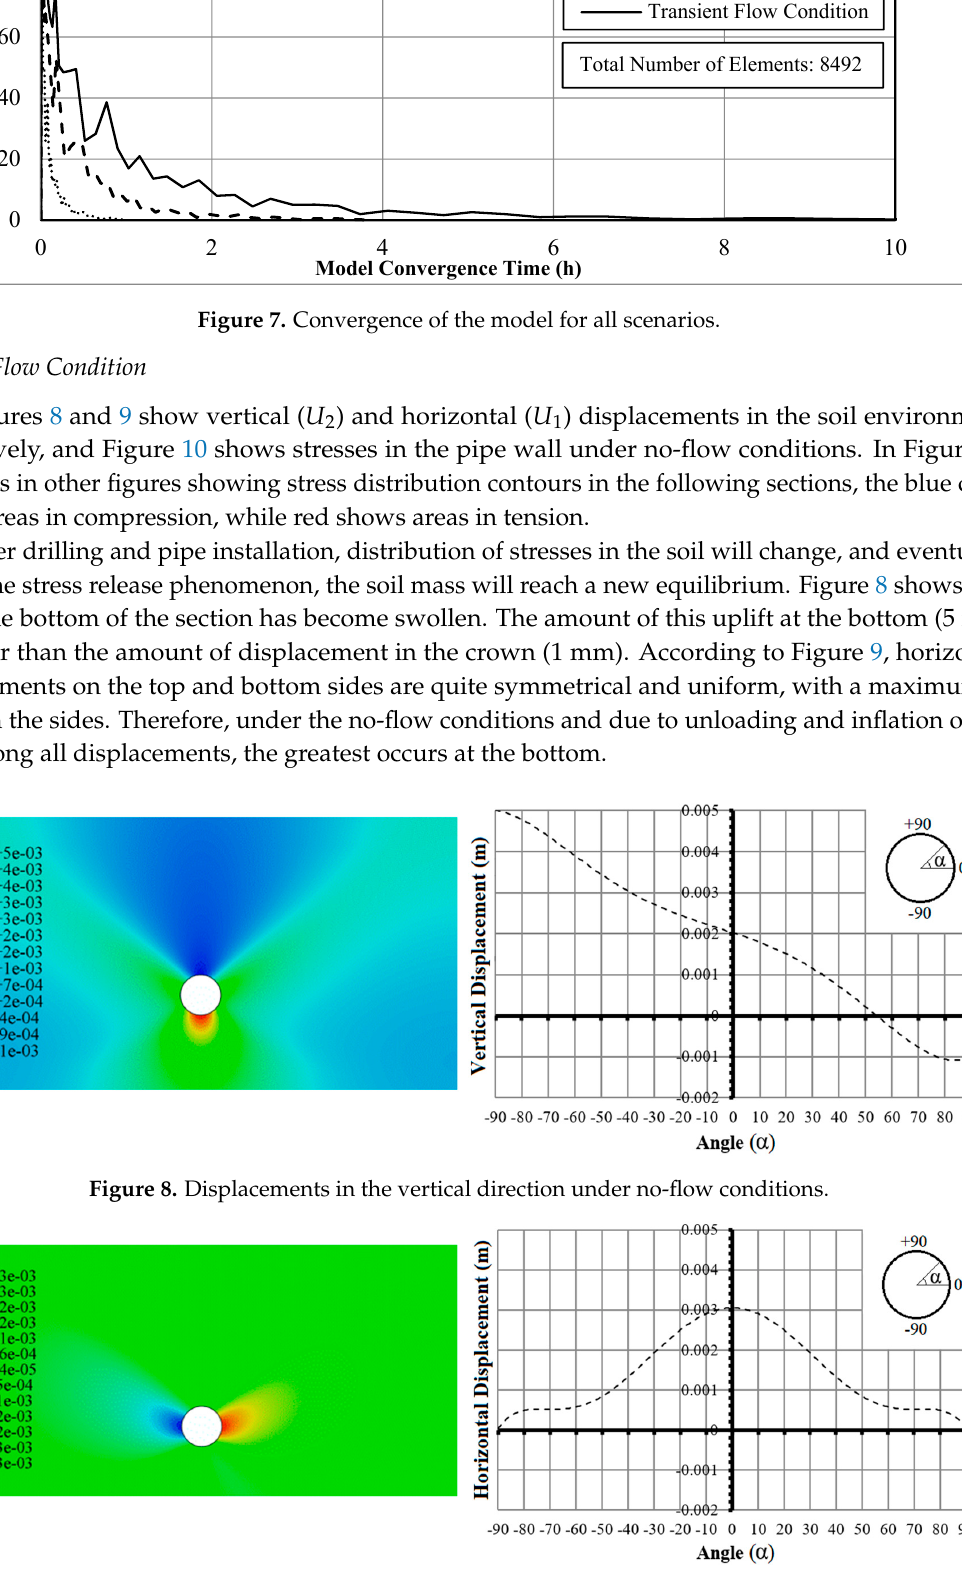
Figure 9. Displacements in the horizontal direction under no-flow conditions.